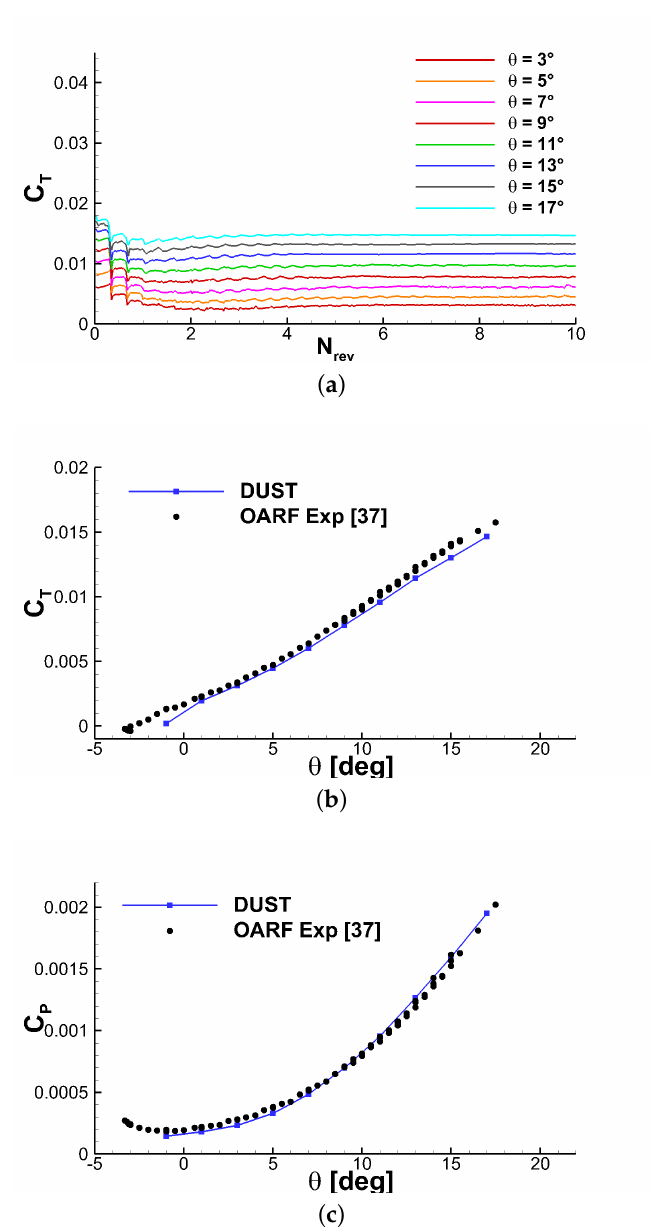
Figure 2. Comparison of the results obtained for the XV-15 full-scale single proprotor in hover. ( a ) Time histories of the thrust coefficient C T calculated by DUST as a function of the number of rotor revolutions N rev ; ( b , c ) comparison of the DUST simulations results with experimental data from